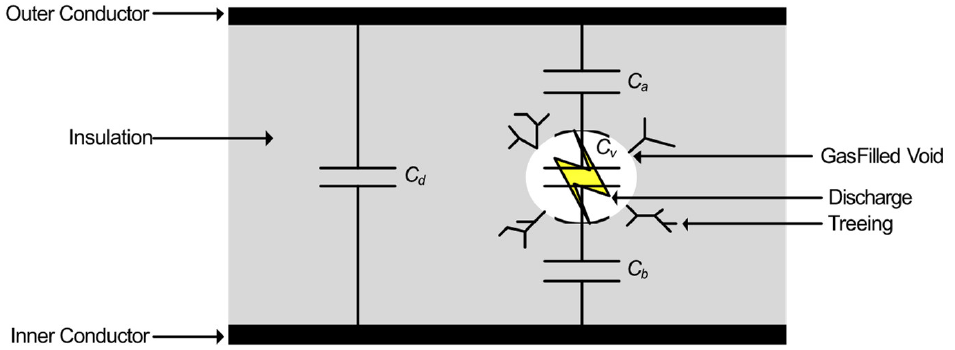
Figure 1. Gemant and Phillippoff gas-filled void partial discharge (PD) model [7]. Cd is the capacitance of the insulation, Cv is the capacitance of the gas-filled void, and Ca and Cb, are the dielectric capacitances in series with the void. As stated earlier, the permittivity of the void is lower than that of the surrounding insulation since the void tends towards the permittivity of air which is lower than that of the insulation; therefore, the electric-field strength within the void is increased and arcing may occur as the AC potential is increased across the conductors. The resulting arcing can weaken the surrounding insulation causing treeing, eventually leading to an increase in the size of the void and a greater risk of catastrophic failure. Figure 2 shows an example of a PD current pulse discharged across an insulation void as a result of the increased field strength within the void [8], where the strength of the PD is quantified by the total charge within it. Typically, the current pulse lasts between 1 and 1000 ns [8,9].